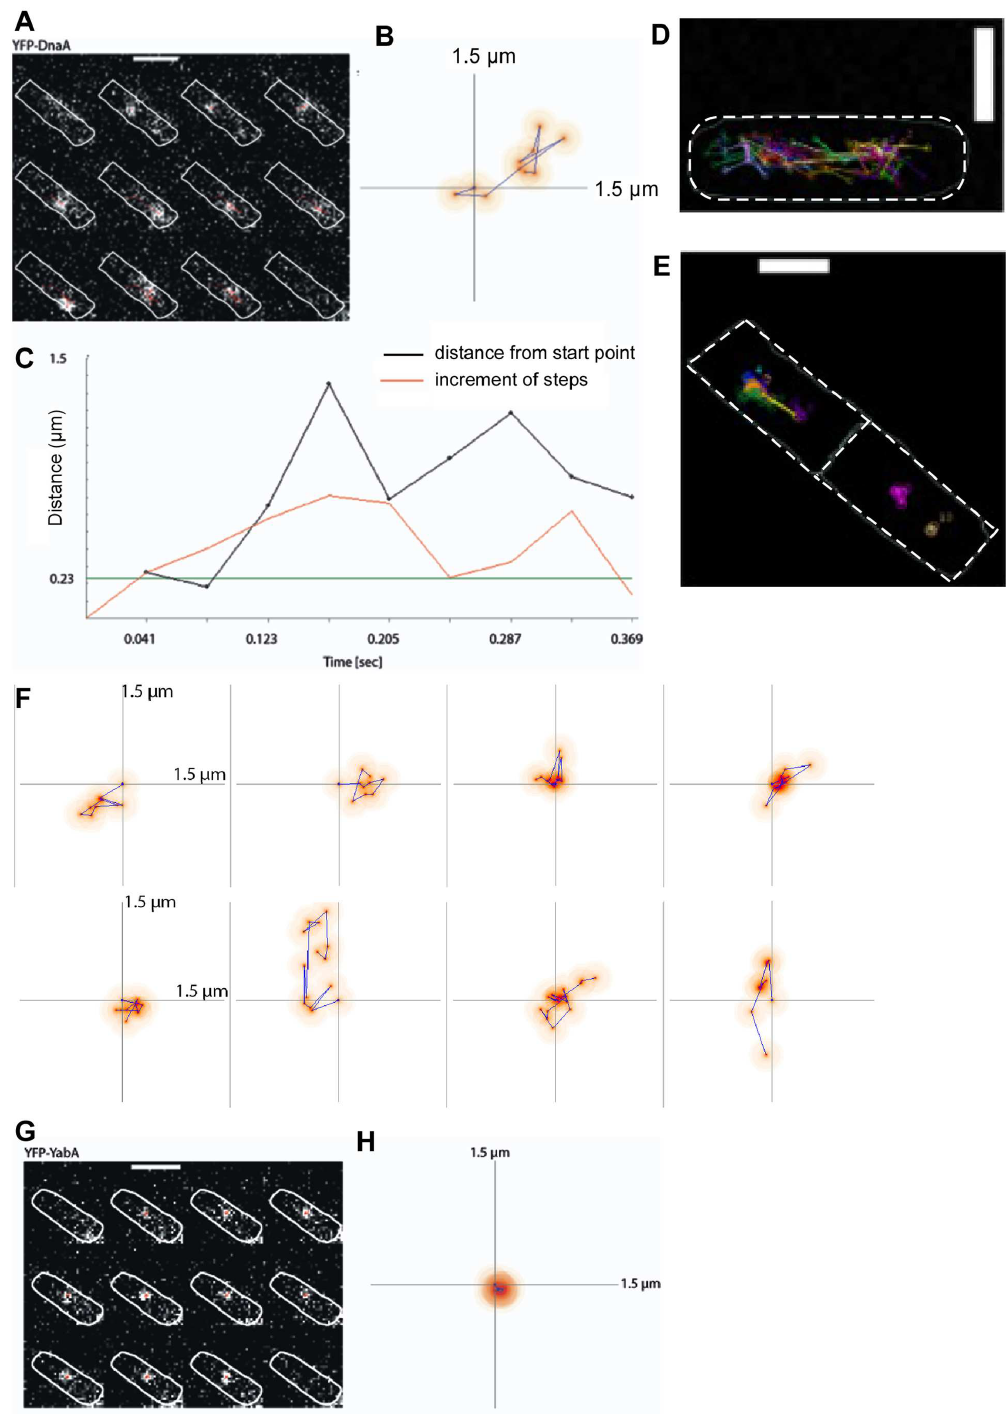
Fig 5. SMT experiments. A) Mobile YFP-DnaA molecule.Image sequenceshowinga singleYFP-DnaA molecule. Each frame correspondsto a time intervalof 41 ms. White line, cell outline; scale bar, 2 μ m. B) Dynamic heat map of the YFP-DnaA trajectory shown in (A). Coordinate plane correspondsto a length of 1.5 μ m. The beginning of the track starts at the point of origin. C) Diagramvisualizingthe distancefrom the origin (black) over time, the increment over time (red) and the definedstopping area (0.23 μ m, green). D) Overlay of many tracks (each indicatedby a different colour) of YFP-DnaA moleculesin a single cell (outlinesindicatedby white line). White bar 2 μ m. E)